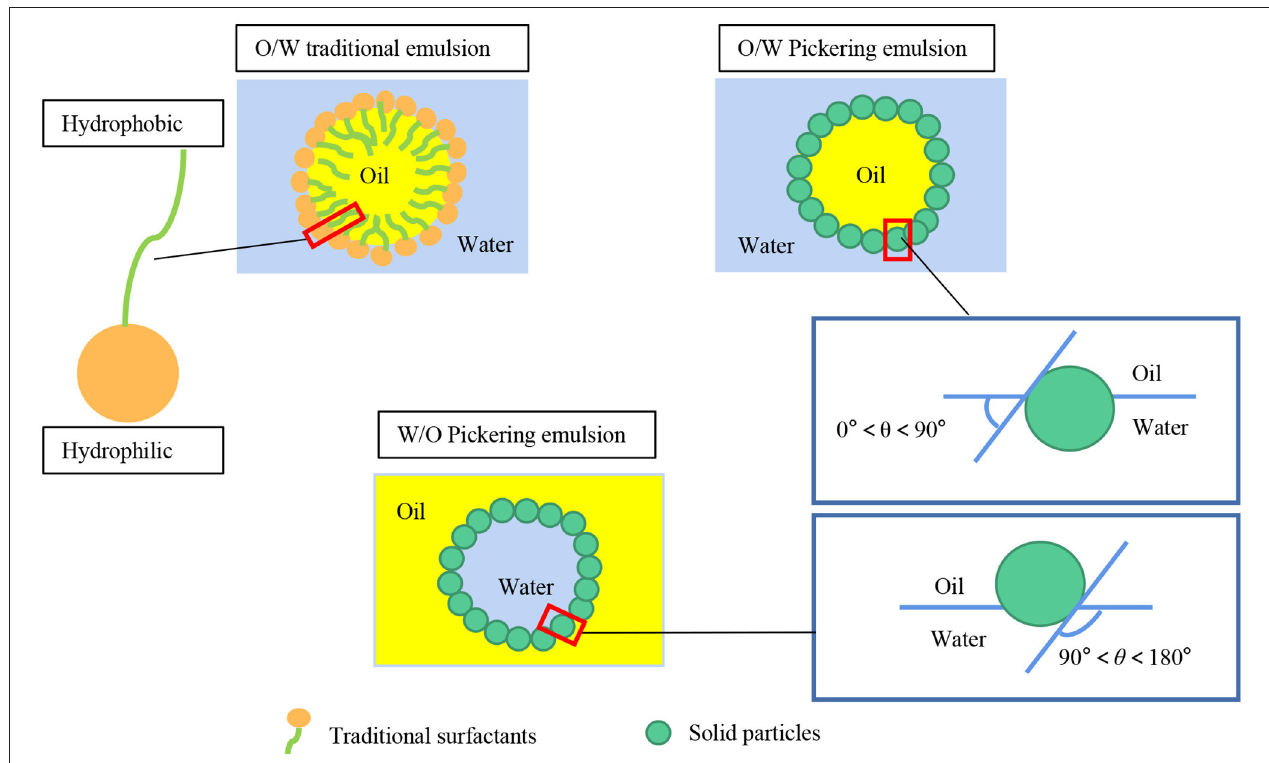
FIGURE 1 | Sketch of traditional emulsions and Pickering